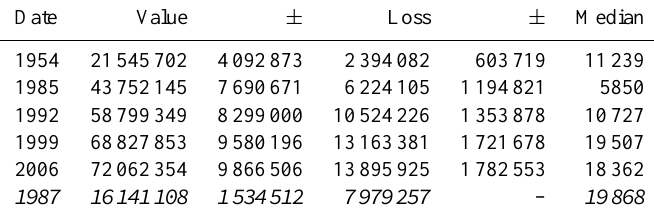
Table 3. Building values and the resulting potential loss in Euro including variance coefficient and mean value between 1954 and 2006. Date Value